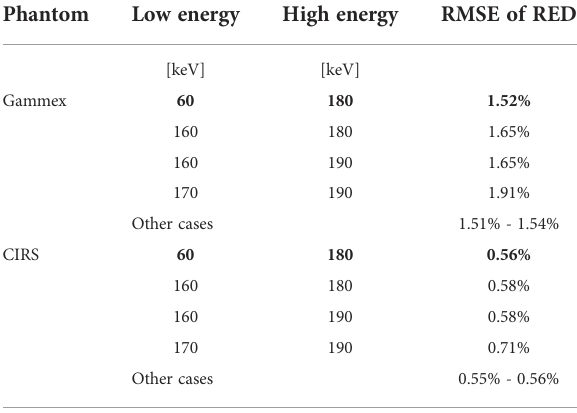
TABLE 5 RMSEs of RED for different monoenergy pairs.